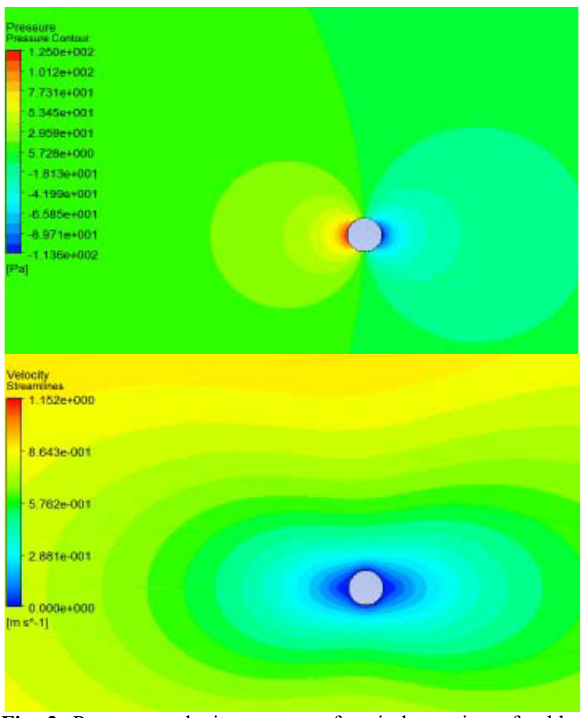
Fig. 2. Pressure, velocity contours for circle section of cable for Re=0,01